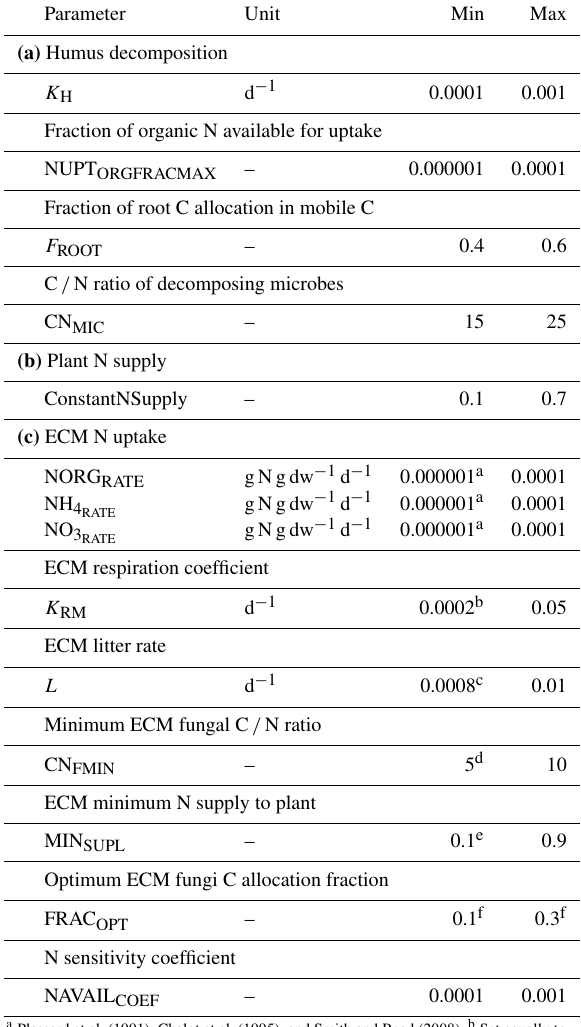
Table 2. Maximum and minimum parameter values prior to Bayesian calibration for the nonlim, implicit, and explicit model approaches. (a) Common parameters (all three approaches). (b) Pa- rameters of the nonlim approach. (c) ECM fungal parameters of the explicit